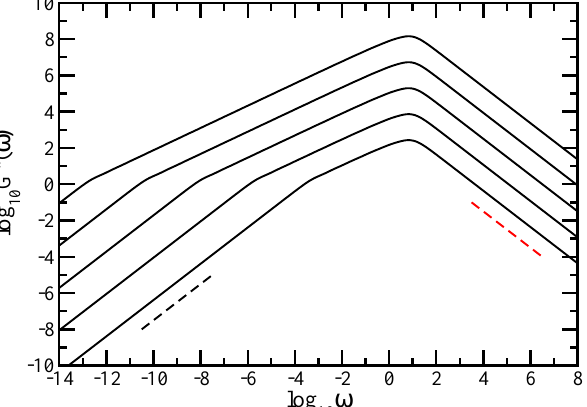
Figure 6. Loss modulus G (cid:48)(cid:48) ( ω ) , displayed in dimensionless units for the fractal cactus networks with N = 3 6 , 3 9 , 3 12 , 3 15 , and 3 18 from below. For guidance, the dashed black line indicates the slope 1 and the red dashed line indicates the slope − 1, Rouse